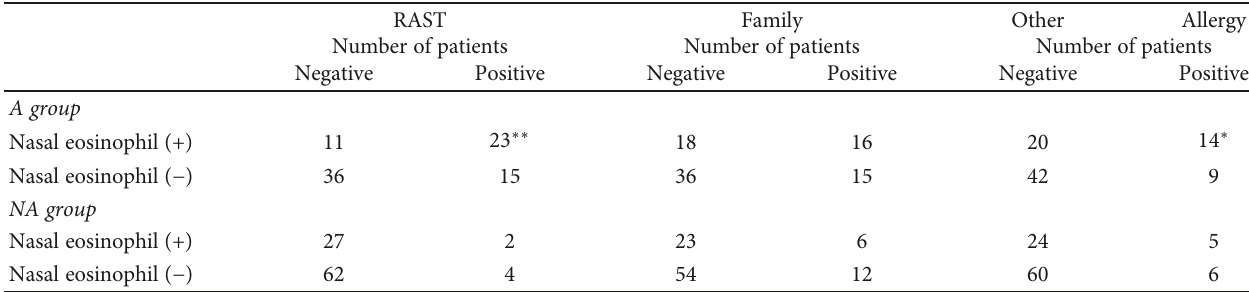
Table 3: Match correlations between nasal eosinophils and other predictive